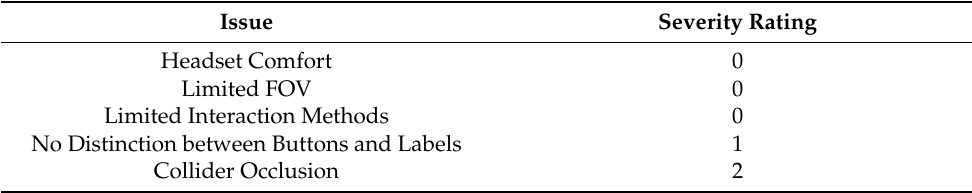
Table 1. Identified usability issues of ARTUR and their severity rating. Lack of comfort, limited FOV, and limited interaction methods were linked to the use of Microsoft HoloLens 1 hardware and received a severity rating of zero. The similarity between UI buttons and labels was labeled as a cosmetic issue with a severity rating of one. Occasional collider occlusion was rated as a minor usability problem with a severity rating of two. Issue Severity Rating Headset Comfort 0 Limited FOV 0 Limited Interaction Methods 0 No Distinction between Buttons and Labels 1 Collider Occlusion